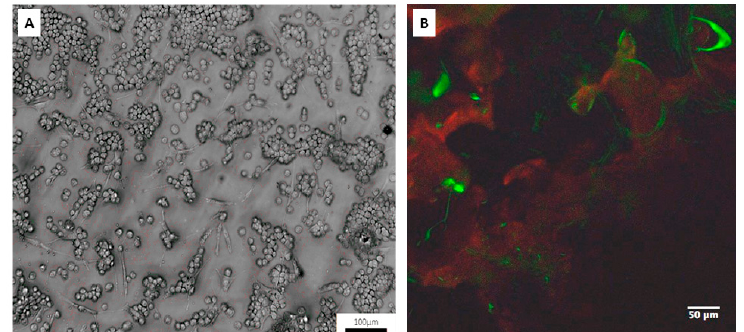
Figure 7. ( A ) Optical (objective 10×) and ( B ) immunofluorescence (objective 40×) analyses on co-cultures containing osteoblasts and macrophages for reproducing in vitro models of bone inflammation.